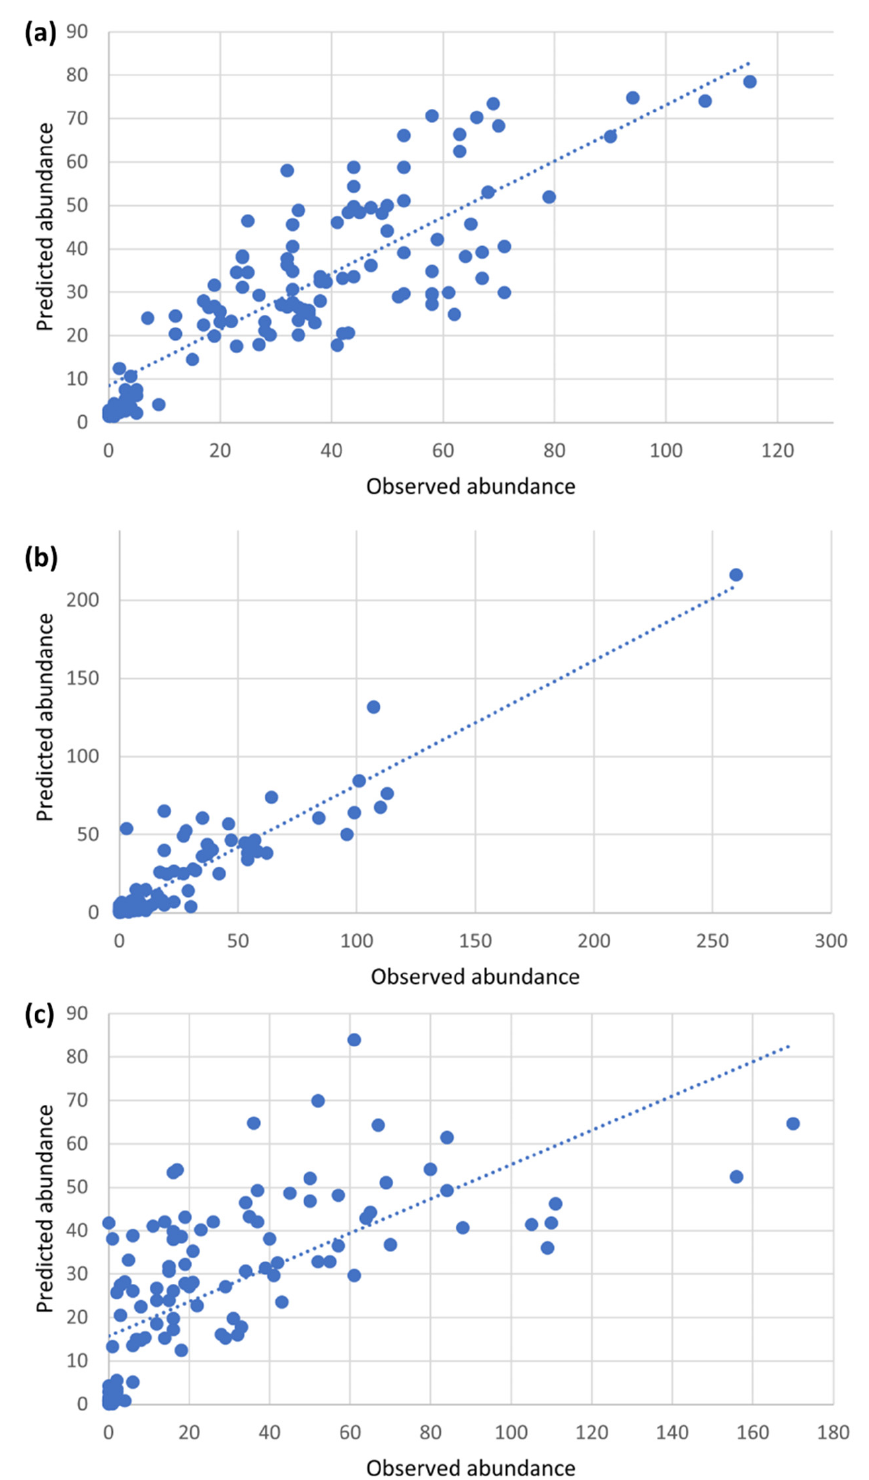
Figure 8. Scatter plots of predicted versus observed mosquito counts for ( a ) An. gambiae s.l. , ( b ) An. funestus , and ( c ) An. paludis .